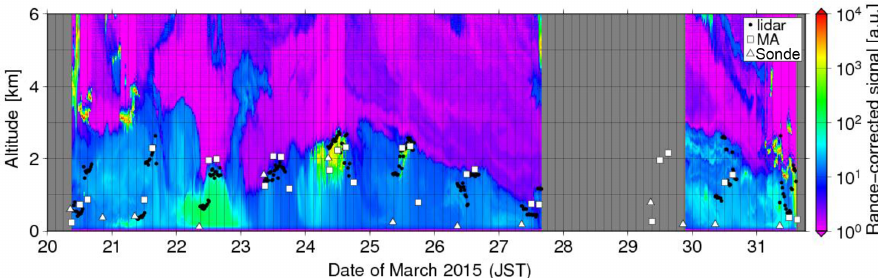
Figure 11. Time–altitude cross section of range-corrected backscatter signal at 1064nm (color shading) and the heights of the mixed layers estimated by Mie lidar (black circles), radiosonde (white triangles), and JMA Meso-Scale Meteorological Analysis (white squares) data over Saga from 09:24JST on 20 March to 14:34JST on 31 March